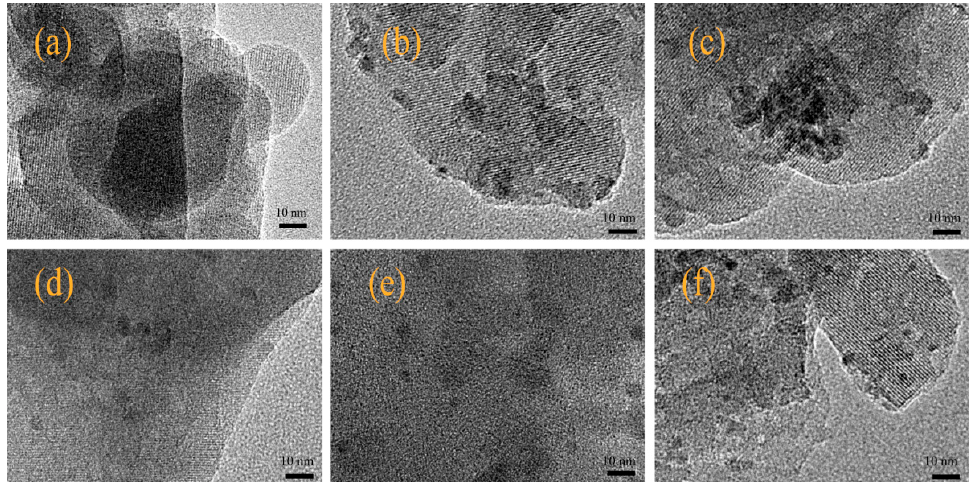
Figure 3. Transmission electron microscopy images of the catalysts with hydrogen pre-treatment. ( a ): HZSM-5; ( b ): Zr/HZSM-5; ( c ): Co/HZSM-5; ( d ): Mo/HZSM-5; ( e ): Ga/HZSM-5; ( f ): Zn/HZSM-5.